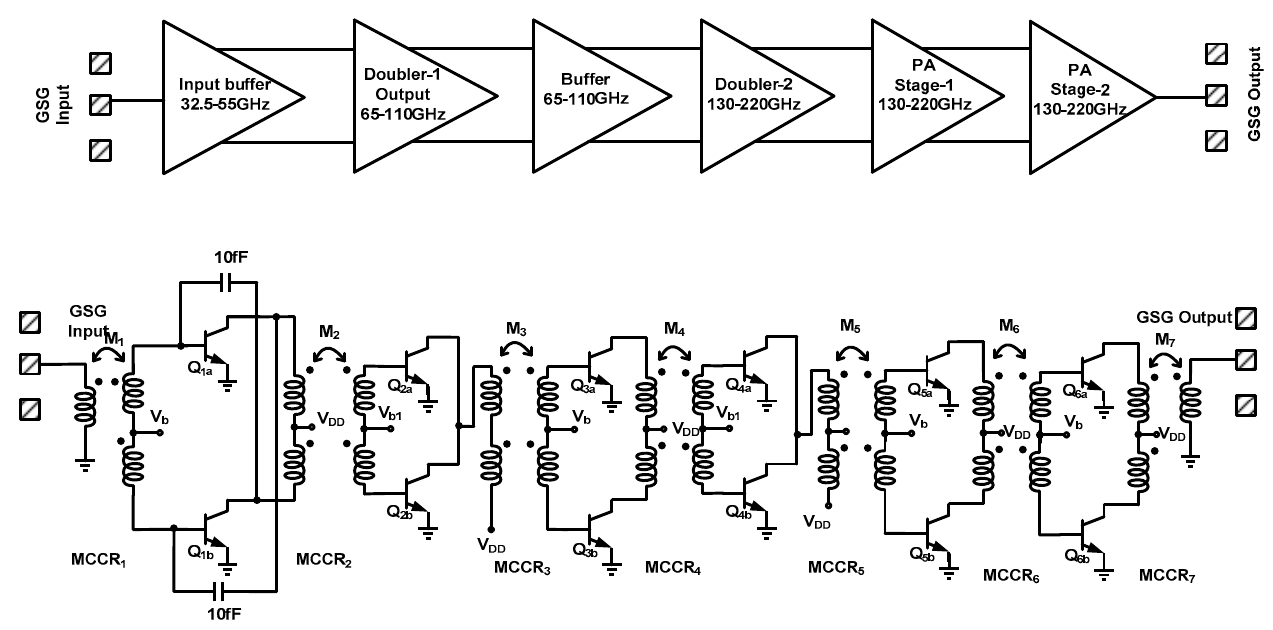
Figure 10. The block diagrams of developed broadband FQ (Frequency Quadrupler).